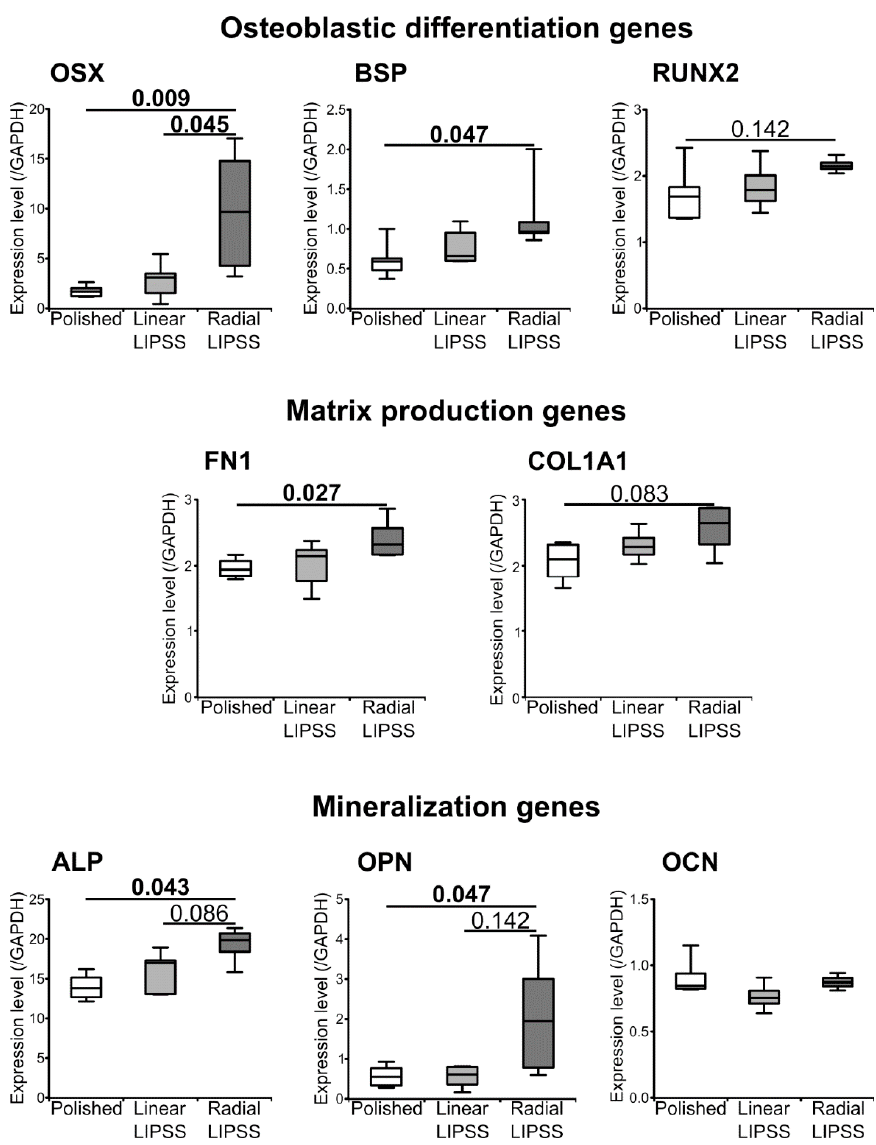
Figure 4. Osteogenic-related genes analyzed by RT-qPCR for cells present on polished, linear LIPSS and radial LIPSS surfaces at 14 d post seeding. Genes are classified by biological function. Values are given as ratios to GAPDH. The graphs give p -values between each group, in bold when <0.05, Mann–Whitney U test, n = 4–6